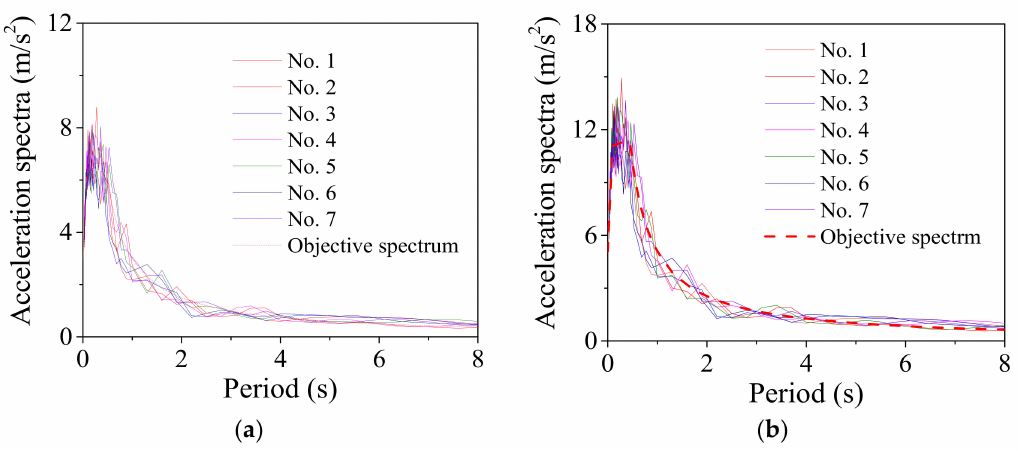
Figure 13. Earthquake spectra together with earthquake motions. ( a ) E1 level; ( b ) E2